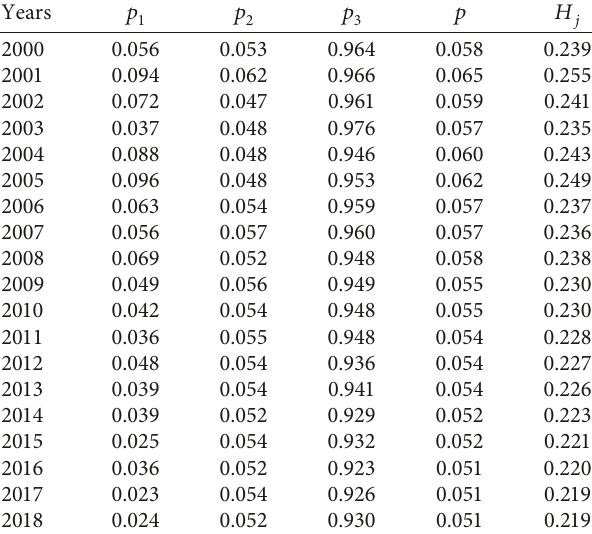
Table 2: Model data